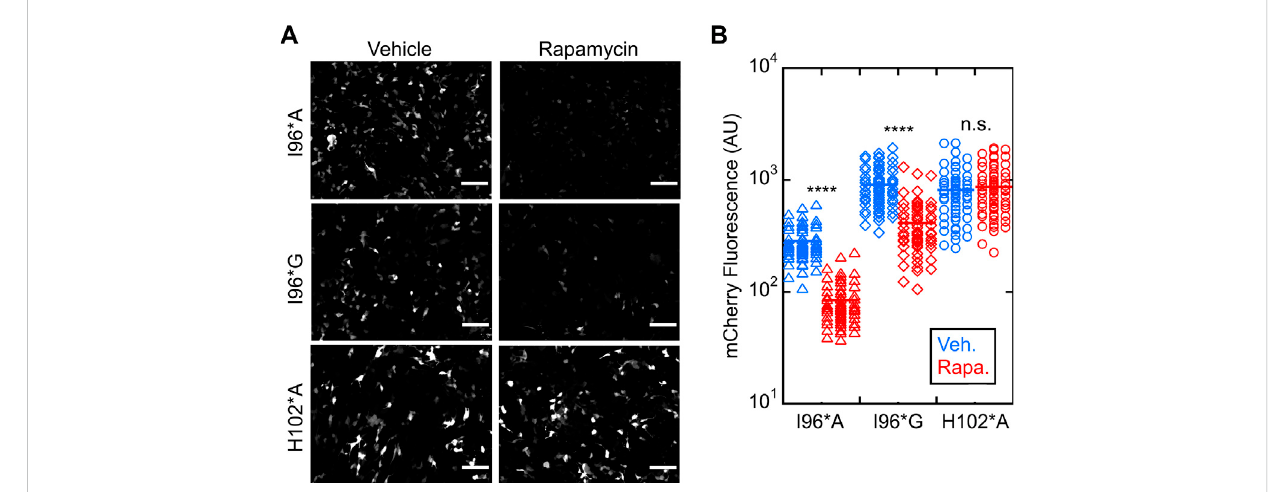
FIGURE 4 Bn-AFF degrades RNA in HEK293T cells upon binding rapamycin. (A) Raw images of cells co-transfected with one plasmid expressing mCherry- PEST reporter and another expressing Bn-AFF mutants I96*A, I96*G or H102*A control showed red fl uorescence when treated with DMSO vehicle, signifying expression of mCherry mRNA. I96*A cells were less fl uorescent than I96*G cells because I96*A had a lower ΔΔ G N/CP value than I96*G, increasing the baseline RNase activity of I96*A. After addition of 2.5 µM rapamycin, fl uorescence decreased in I96*A and I96*G cells, indicating mCherry mRNA degradation. (B) Quanti fi cation revealed 3.4-fold and 2.2-fold decreases in fl uorescence of I96*A and I96*G cells, respectively, in the presence of rapamycin compared to vehicle. No signi fi cant change was observed in the catalytically inactive control. Three images were used for quanti fi cation of mCherry fl uorescence. The number of cells analyzed were 60 (I96*A, vehicle), 60 (I96*A, rapamycin), 58 (I96*G, vehicle), 62 (I96*G, rapamycin), 59 (H012*A, vehicle), and 65 (H102*A, rapamycin). Each dot represents a cell. A t -test with unequal variance was performed to test